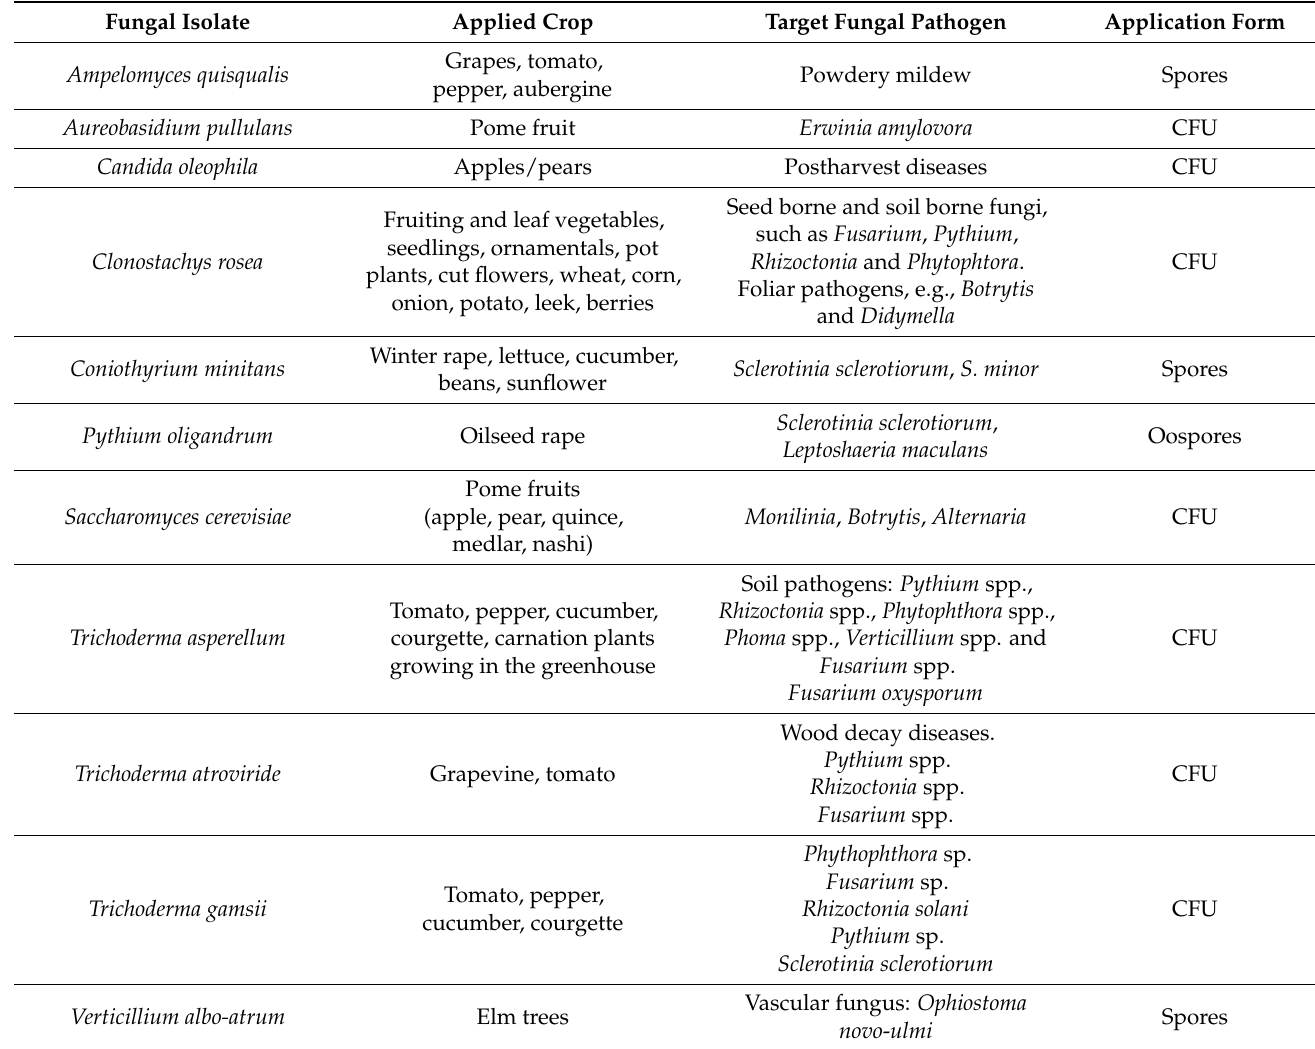
Table 2. Fungal species authorized by the European Union to be applied against fungal